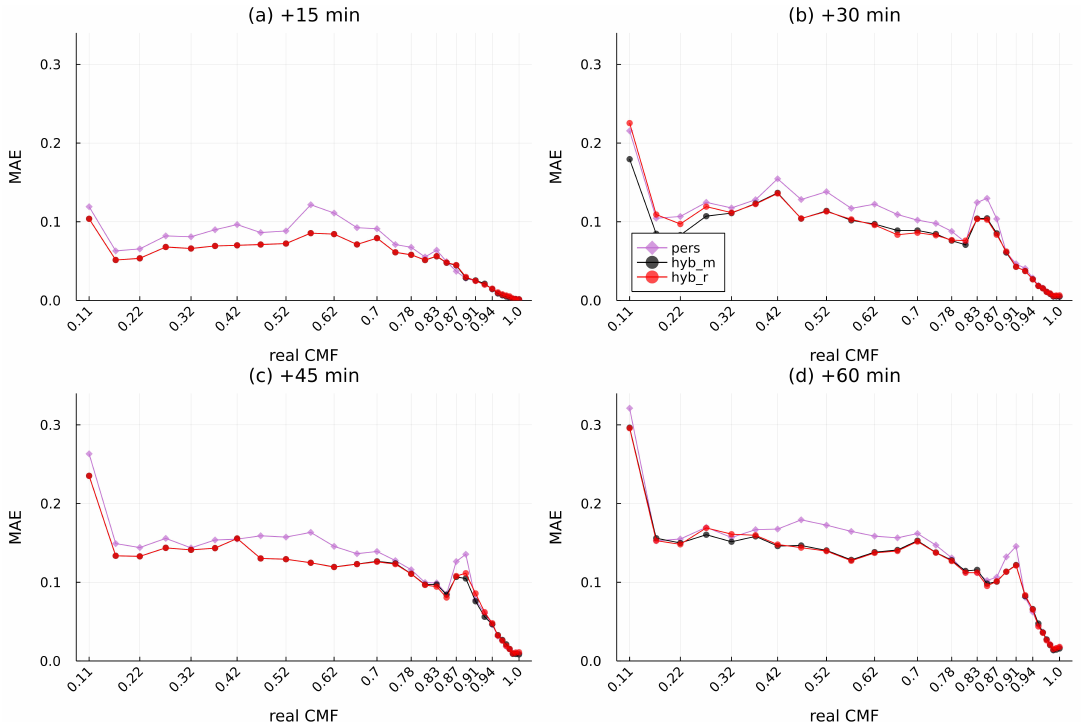
Figure A5. MAE for each CMF class for ( a ) 15 min, ( b ) 30 min, ( c ) 45 min, and ( d ) 60 min ahead in 2020 for Bucharest.